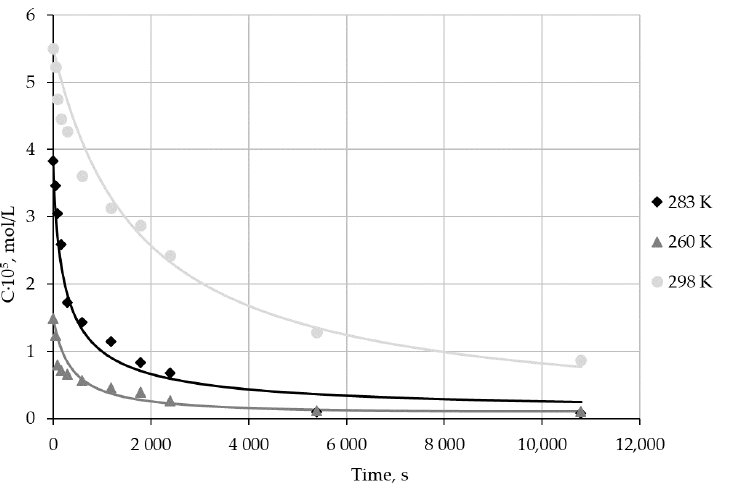
Figure 8. Dependencies of the H 2 S concentration change on time during sorption on model samples containing MnO 2 at different temperatures.